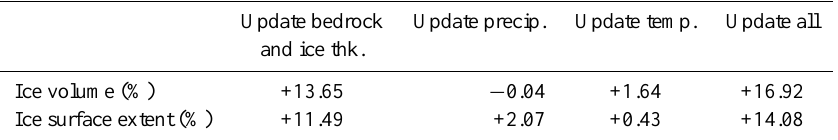
Table 3. Summary of the relative difference between updated boundary condition/forcing and the EISMINT-3 datasets. Positive values correspond to an increase and negative values a decrease in ice volume/ice surface extent. Note when all boundary conditions/forcings are updated the relative change almost equals the sum of the individual changes.